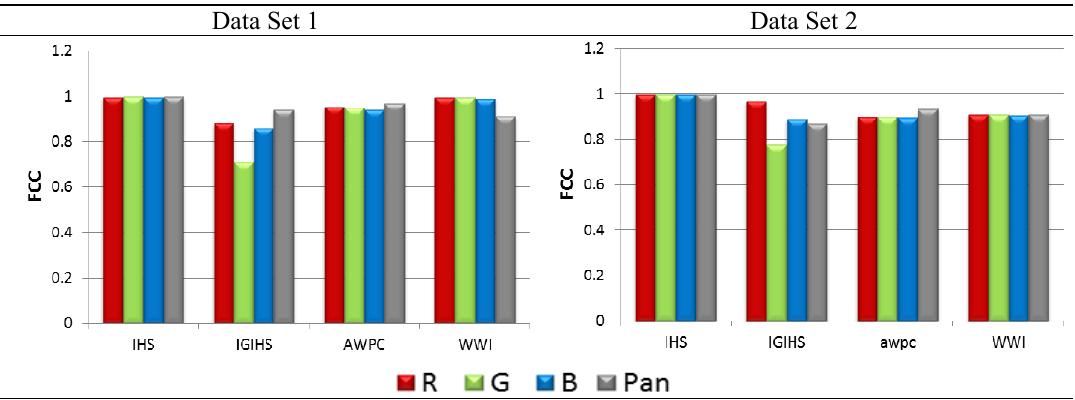
Figure 6. Results of FCC spatial quality assessment metric.